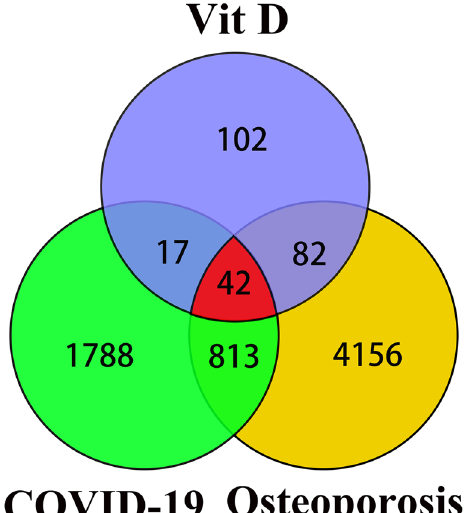
Figure 1. Venny diagram of the association of VitD targets with osteoporosis and COVID-19 targets. A total of 243 VitD targets, 2660 COVID-19 targets, and 5093 osteoporosis targets were identified. There exist 855 common targets between COVID-19 and osteoporosis, 59 common targets between VitD and COVID-19, 124 common targets between VitD and osteoporosis, and 42 common targets among VitD, COVID-19 and